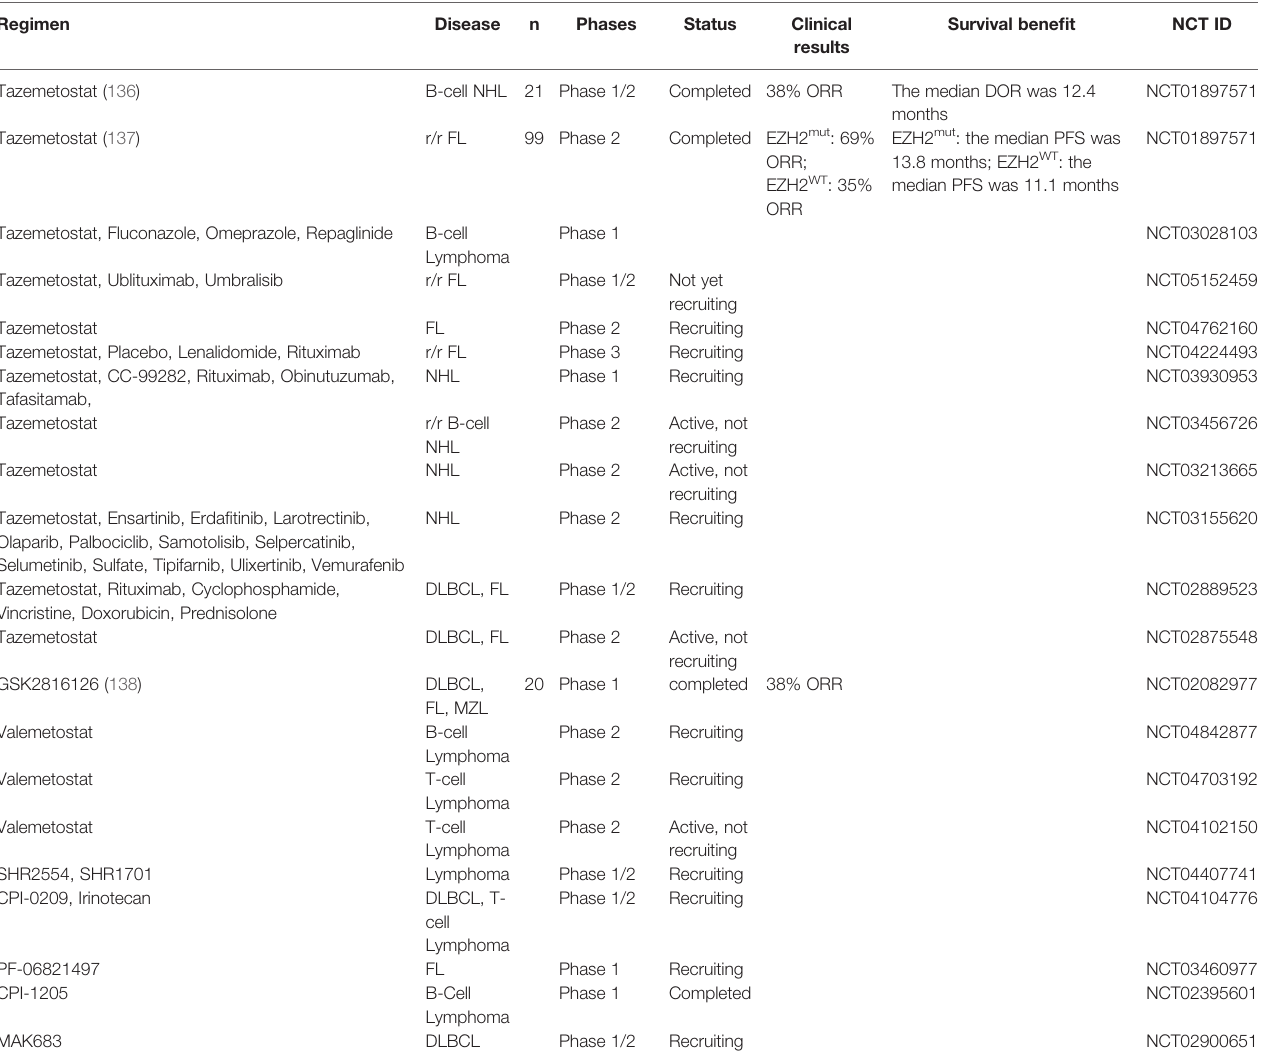
TABLE 2 | Clinical trials of EZH1/2